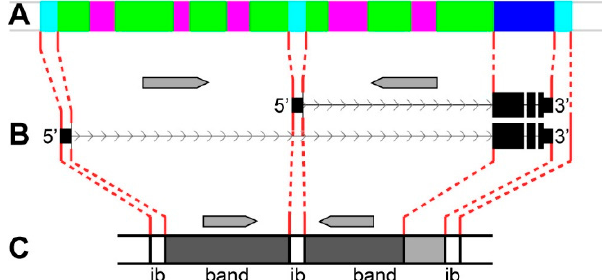
Figure 22. The scheme of the two bands and three interbands formation from the gene material with two introns and two alternative promoters of the predominant long “main” gene; grey arrows represent shorter genes located within the introns of the “main” gene. ( A ) the four chromatin-state model [39]; ( B ) exons and introns of the dlg1 gene; and, ( C ) polytene chromosome bands and interbands (ib) structure comprising genes studied.